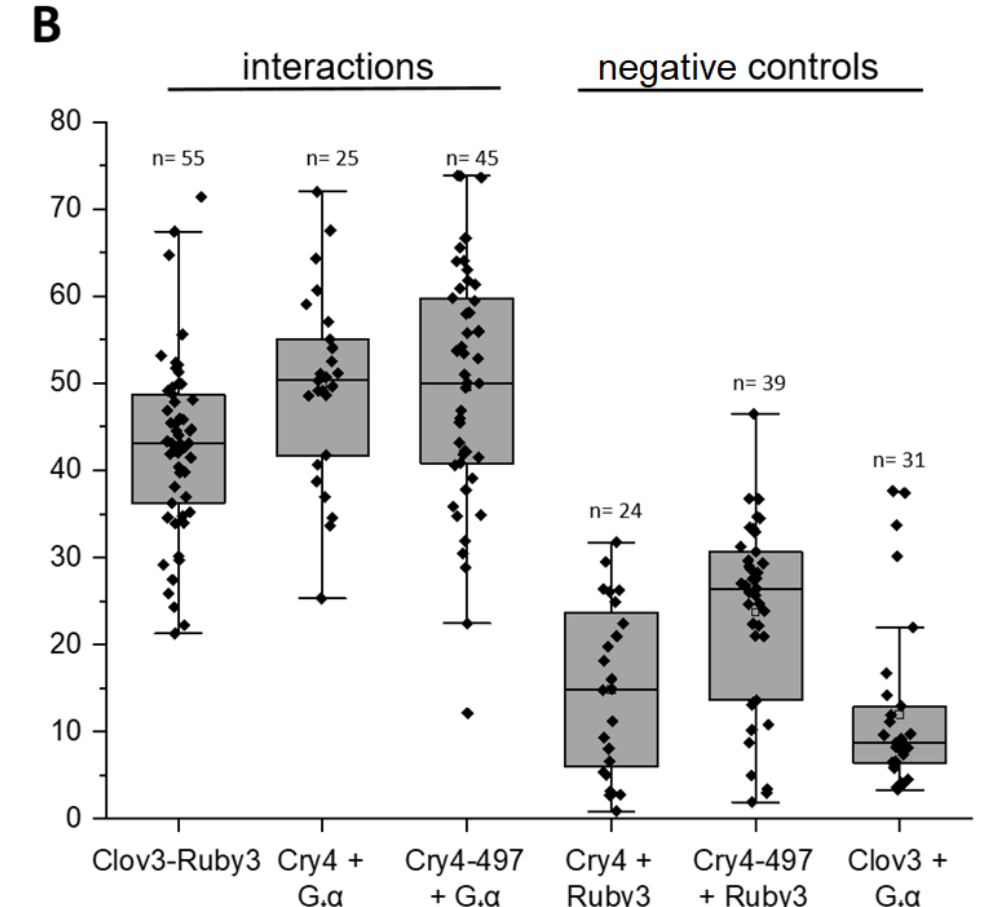
Figure 4. Interaction between G t α and Er Cry4a with and w/o C-terminus ( Er Cry4-497) using the acceptor photobleaching FRET technique. ( A ) Representative confocal laser scanning microscopy images of QNR/K2 cells before and after photobleaching (overlay of red-donor and green-acceptor), and FRET efficiencies. Expressed proteins as indicated. The green rectangular indicates the bleached area. Scale bar is 10 µ m. ( B ) FRET efficiencies as determined by the LAS AF software between N-terminally tagged Cry4 (or the truncated version Cry4-497) with mClover3 (Clov3) and G t α , C-terminally tagged with mRuby3 (Ruby3), including negative and positive controls. Boxplot graphs were generated using Origin graph software. The boxes range from Q1 (the first quartile) to Q3 (the third quartile) of the data distributions, and the range represents the IQR (interquartile range). Medians are indicated by lines across the boxes. The whiskers extend between the most extreme data points, excluding outliers, which are defined as being outside 1.5 × IQR above the upper quartile and below the lower quartile. Each data point represents the measurement for one cell, with n indicating total cell numbers measured in each condition. Each condition was tested in at least three separate experiments.